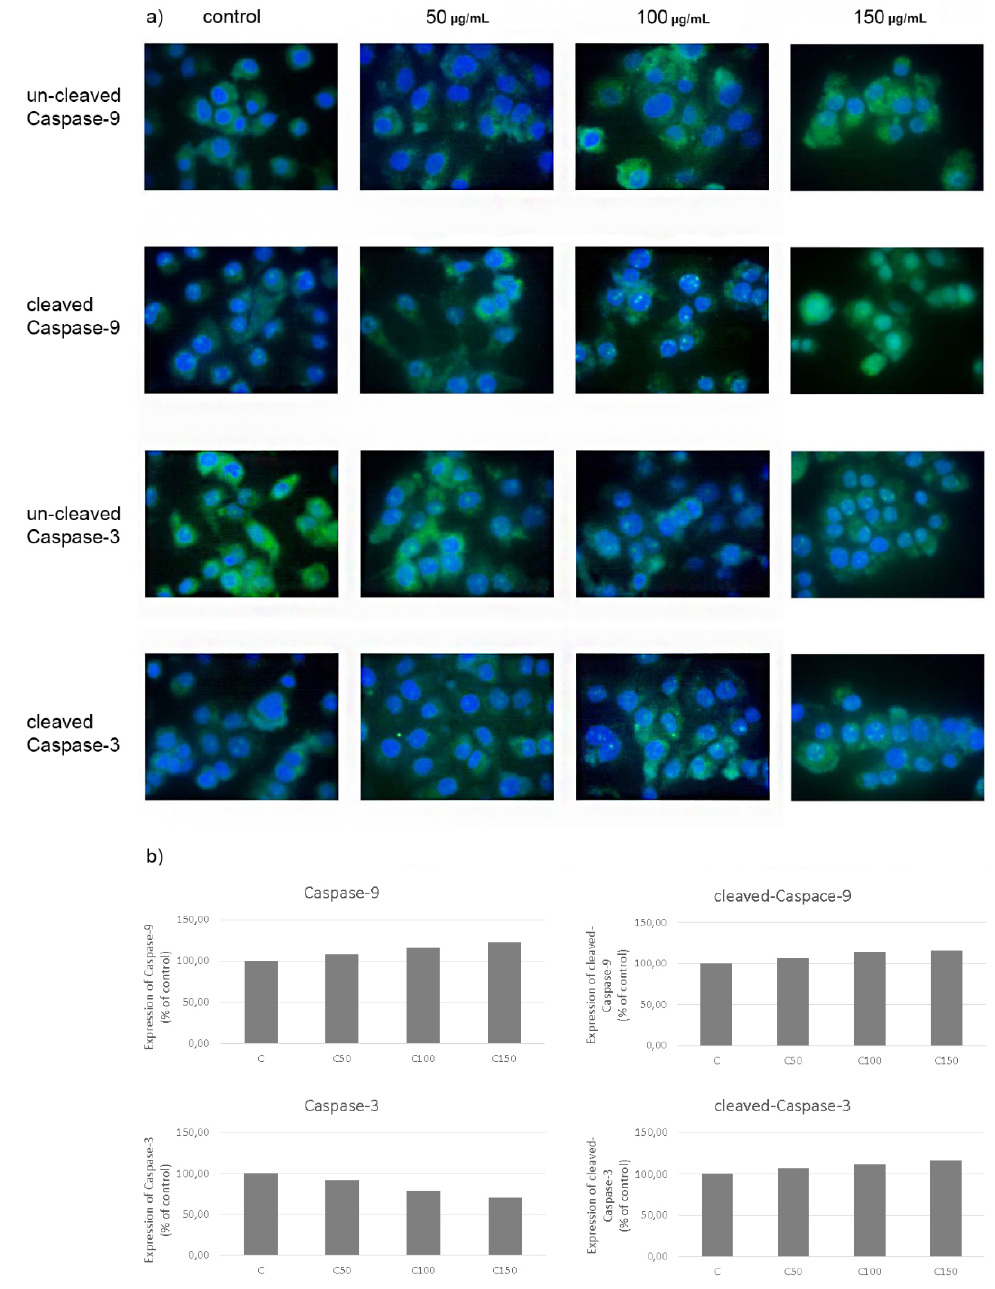
Figure 7. Expression of caspases-3 and 9 (cleaved and un-cleaved) in CAL-27 cancer cells after incubation with celecoxib ( a ) with quantification data ( b ).